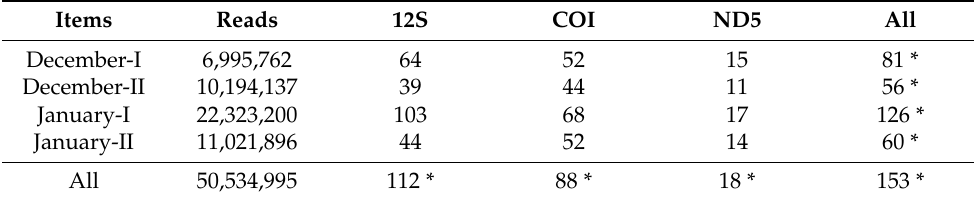
Table 2. Summaries for the number of fish species based on the sequencing reads of 12S, COI, ND5 in 4 eDNA samples collected from two different dates and